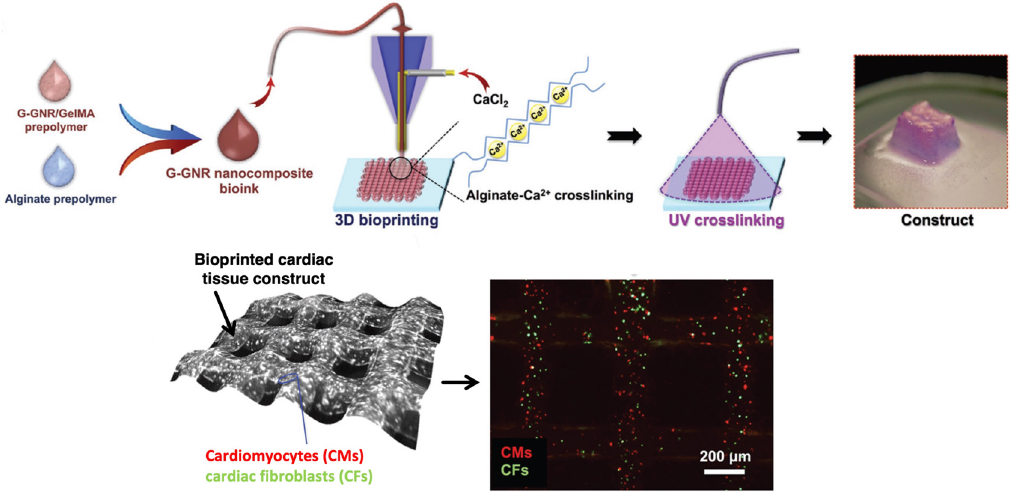
Figure 4. Schematic showing 3D bioprinting using GelMA-coated gold nanorod (G-GNR) nanocom- posite bioink. Bright field image shows homogeneously distributed cardiomyocytes and cardiac fibroblasts in bioprinted cardiac tissue construct. Adapted with permission from [114], 2022, Wiley VCH Verlag GmbH & Co KGAA.